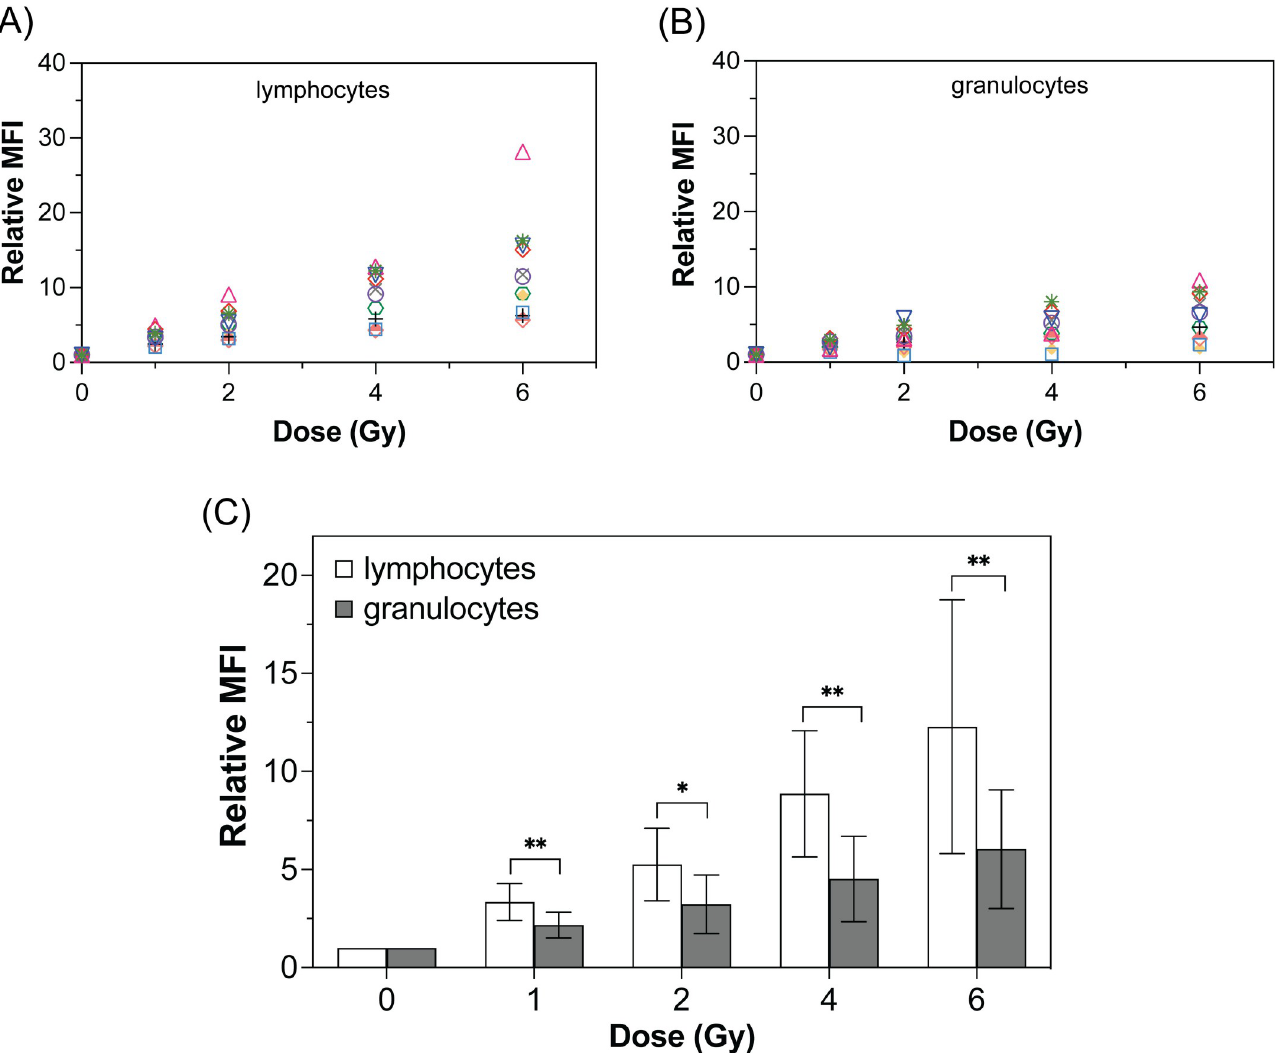
Fig 2. Dose responses of γ -H2AX expression in lymphocytes and granulocytes by flow cytometry. Relative MFI of white blood cell population vs doses for (A) lymphocytes and (B) granulocytes. Each dot in different colors represents an individual donor (n = 11). All p -values < 0.05; 0 Gy vs 2, 4, 6 Gy; 1 Gy vs 4, 6 Gy; 2 Gy vs 6 Gy for both lymphocytes and granulocytes. (C) Error bar represents the comparison of relative MFIs of lymphocytes and granulocytes at the same dose. Symbols � and �� correspond to p- values of less than 0.05 and 0.01,